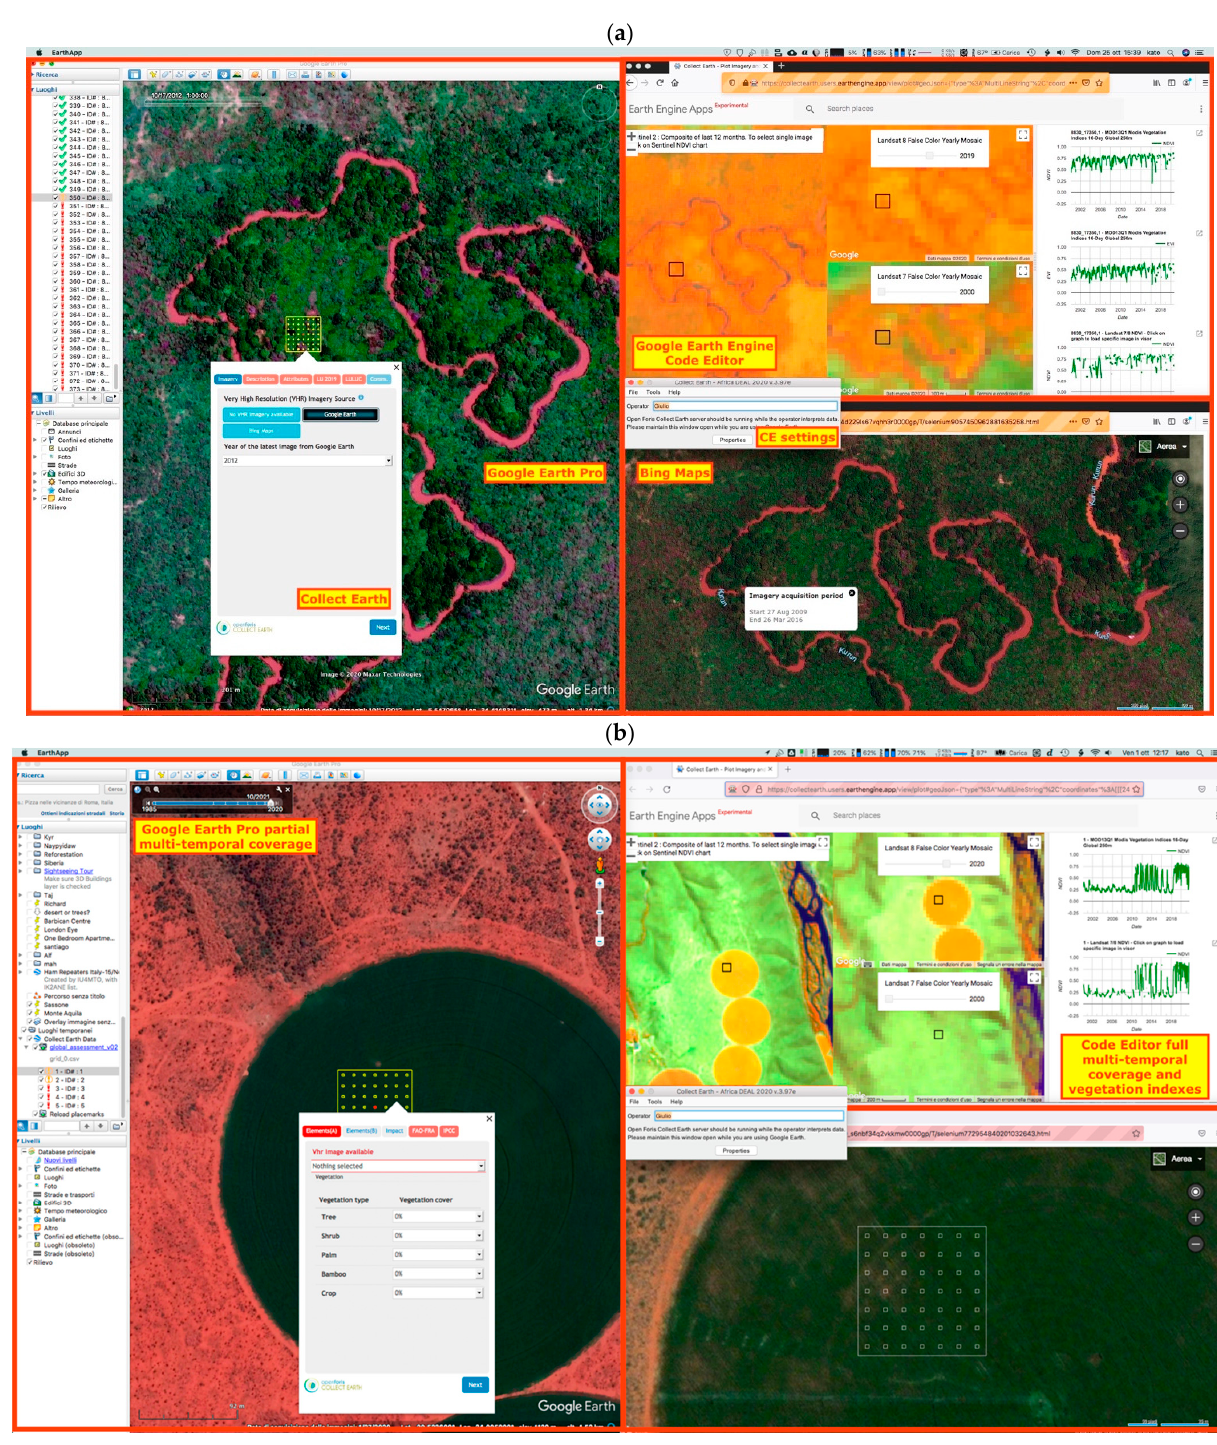
Figure 1. Two examples of the Collect Earth Interface, illustrating a sample plot (yellow box with dots in left image) to be assessed in ( a ) South Sudan and ( b ) in South Africa in Collect Earth through Google Earth Pro, in Google Earth Engine Code Editor (in the top right image) including various vegetation indices and the sample plot in a high-resolution image in Bing Maps (bottom right). Example ( b ) also shows the Collect Earth assessment of a plot with an NDVI peak well above 0.25 (in this case, reaching 0.75). NDVI values between 0.25 and 0.40 represent soils with vegetation, while values above 0.40 represent vegetated surfaces.